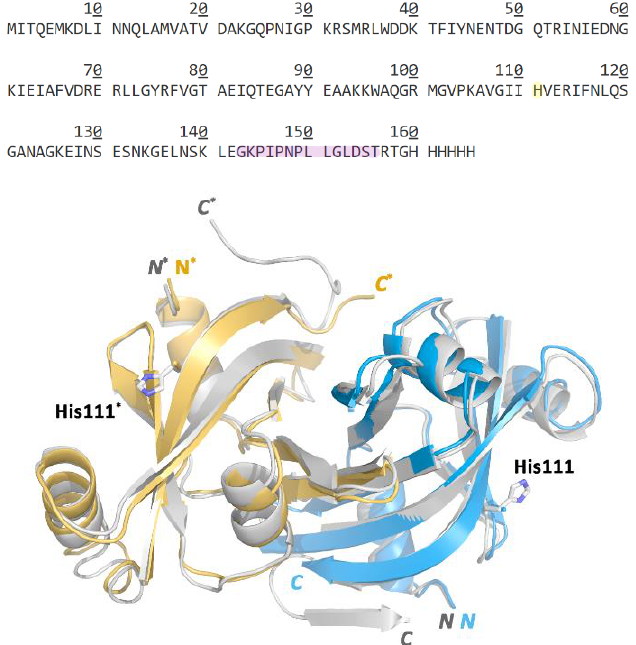
Figure 7. Superposition of the crystal structure of wild-type (PDB entry: 7KPZ) and H111A HupZ (7KQ2). Wild-type HupZ is shown in gray color. Chains A and B of the H111A variant are in blue and orange, respectively. His111 residues in wild-type HupZ and Ala111 residues in the H111A variant are shown as sticks with the His111 residues labeled. The N and C terminus of wt and mutant are labeled. Chain B residues and are labeled with * . The top image is the amino acid sequence of HupZ with His111 highlighted in yellow and the 14-residue V5 epitope tag highlighted in purple.